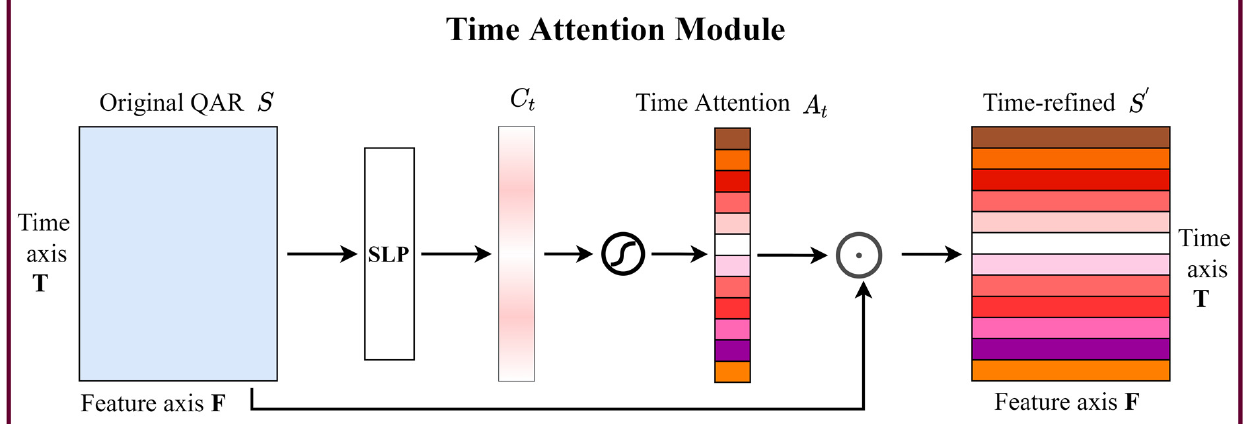
Figure 5. Diagram of the time attention module.